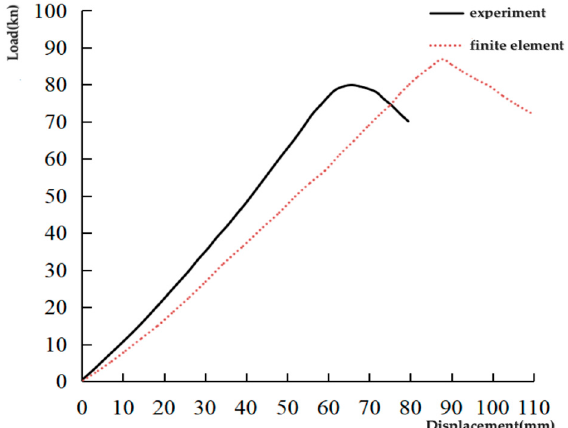
Figure 7. Comparison of JD-4 load-displacement curves.